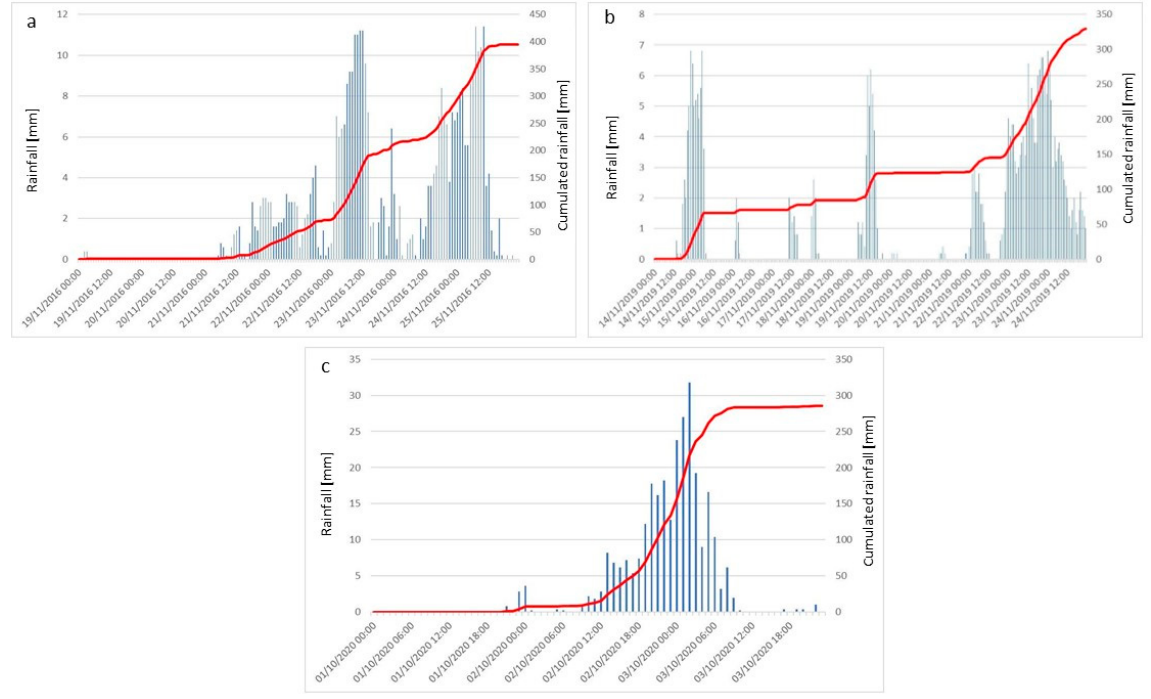
Figure 8. Rainfall path of the ( a ) November 2016; ( b ) November 2019; and ( c ) October 2020 events. Figure 8. Distribution of interstitial pressures in the slope (Section A–A’) during selected storm phases: ( a ) November 2016 event; ( b ) November 2019 event; and ( c ) October 2020 event. The blue line in each section represents the vertical transect for which interstitial pressure variations were analysed and graphed. 1 Layer 1; and 2 Layer 2.